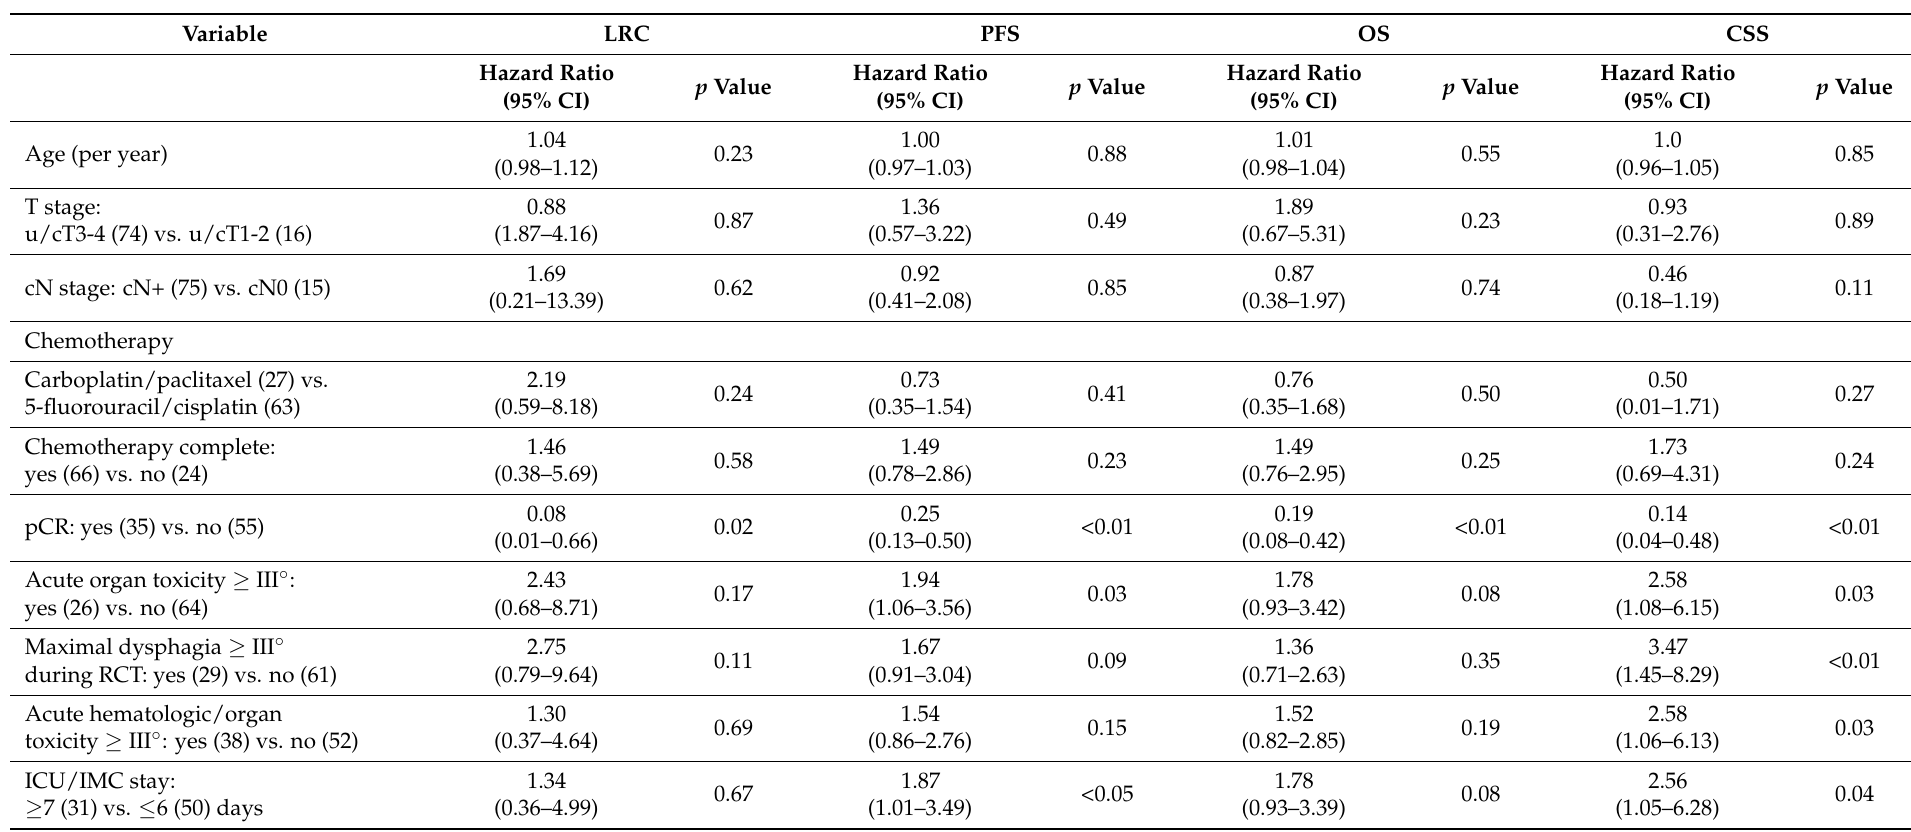
Table 4. Univariate Cox regression analysis including patient baseline, tumor- and treatment- related variables, and toxicities and complications. The hazard ratios and 95% confidence intervals are given. p values < 0.05 were considered as statistically significant. LRC: Locoregional control, PFS: Progression-free survival, OS: Overall survival, CSS: Cancer-specific